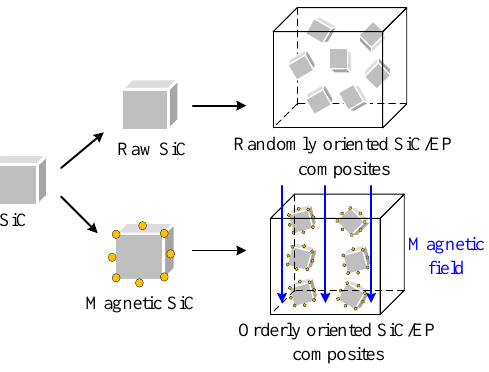
Figure 3. Schematic diagram of the randomly oriented SiC/EP composites and orderly oriented SiC/EP composites.